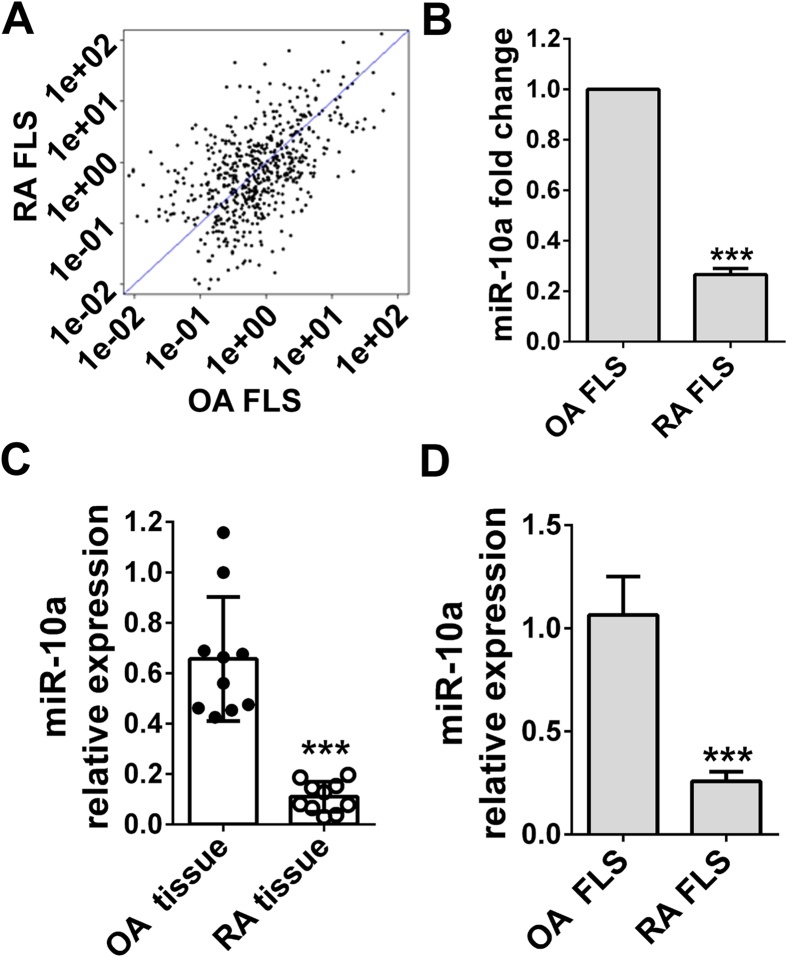
miR-10a is downregulated in the synovial tissues and FLSs of RA patients.(A) Total RNA was isolated from FLSs that were isolated from RA and OA patients and subjected to microRNA microarray analysis on the Lianchuan human genome microRNA array. The miRNA expression profiling data are shown with scatter plots. One representative of three experiments is shown. The top ten differentially expressed miRNAs in RA FLSs are shown in a heat map diagram (supplementary Fig. S1). (B) The miR-10a levels detected using the microarray were normalized to a negative control of random sequences of similar sizes. (C) Quantitative PCR validation of the microRNA microarray. Synovial tissues were collected from RA (n = 10) and OA (n = 10) patients. Total mRNA was extracted, and the miR-10a expression level was analyzed through quantitative real-time PCR and normalized to the U6B housekeeping microRNA gene. (D) miR-10a expression was downregulated in the FLSs of RA patients compared with OA patients. ***P < 0.001 compared with the OA group. The results are expressed as percentages of the control mean values ± SD for three independent experiments.